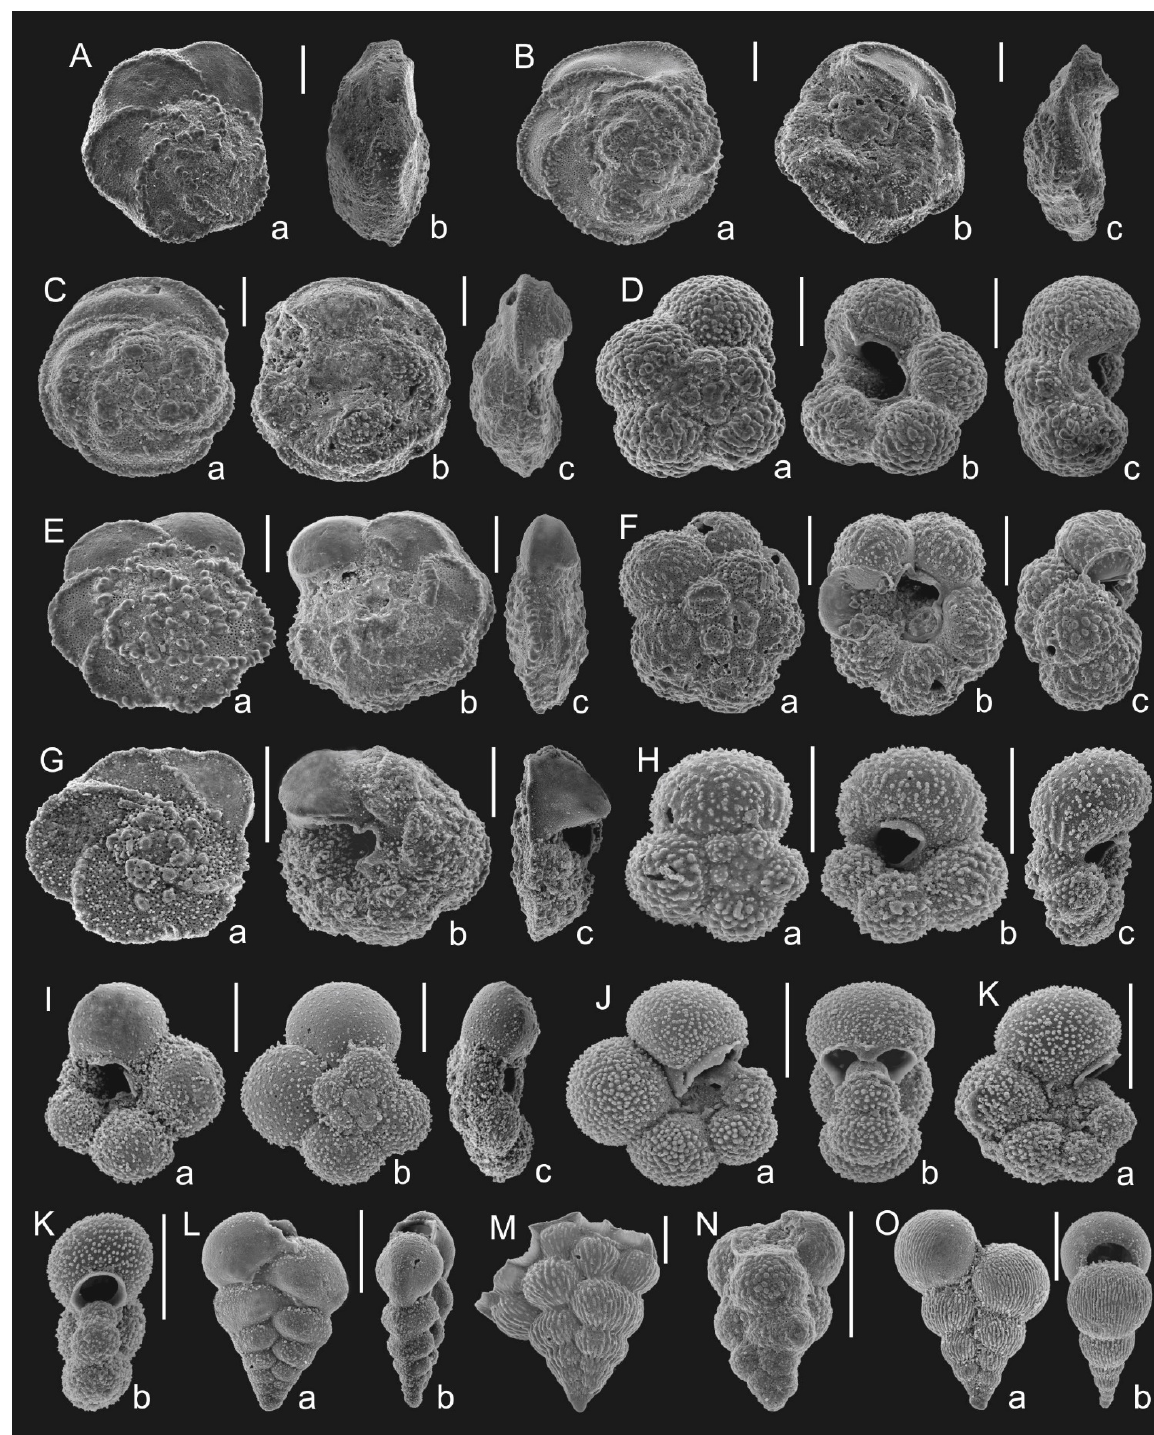
Figure 7. Planktonic foraminifera from the Jeżówka ( A ), Ciszyca Górna ( B , C ), Kłudzie ( D , F ), and Sulejów ( E ) outcrops, Polanówka UW-1 borehole ( G , H , J – M ), Chełm quarry ( I , O ) and Nasiłów outcrop ( N ); A ( a , b ). Globotruncana ventricosa ; B ( a – c ). Contusotruncana fornicata ; C ( a – c ). Contusotruncana plummerae ; D ( a – c ). Rugoglobigerina rugosa ; E ( a – c ). Globotruncana rugosa ; F ( a – c ). Rugoglobigerina pennyi ; G ( a – c ). Globotruncanita pettersi , depth 90.3 m; H ( a – c ). Globotruncanella minuta , depth 79.6 m; I ( a – c ). Globotruncanella petaloidea ; J ( a , b ). Globigerinelloides multispinus , depth 74.85 m; K ( a , b ). Globigerinelloides prairiehillensis , depth 86.4 m; L ( a , b ). Laeviheterohelic glabrans , depth 74.9 m; M . Planoglobulina brazoensis , depth 81.1 m; N . Guembelitria cretacea ; O ( a , b ). Planoheterohelix striata . Scale bar = 100 µ